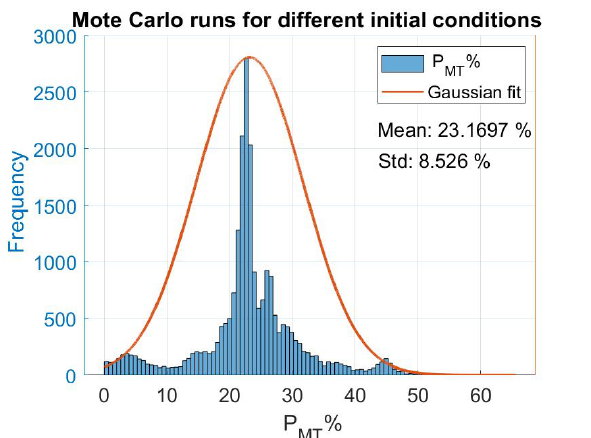
Figure 12. Gaussian distribution and histogram of improvement percentage in maneuver